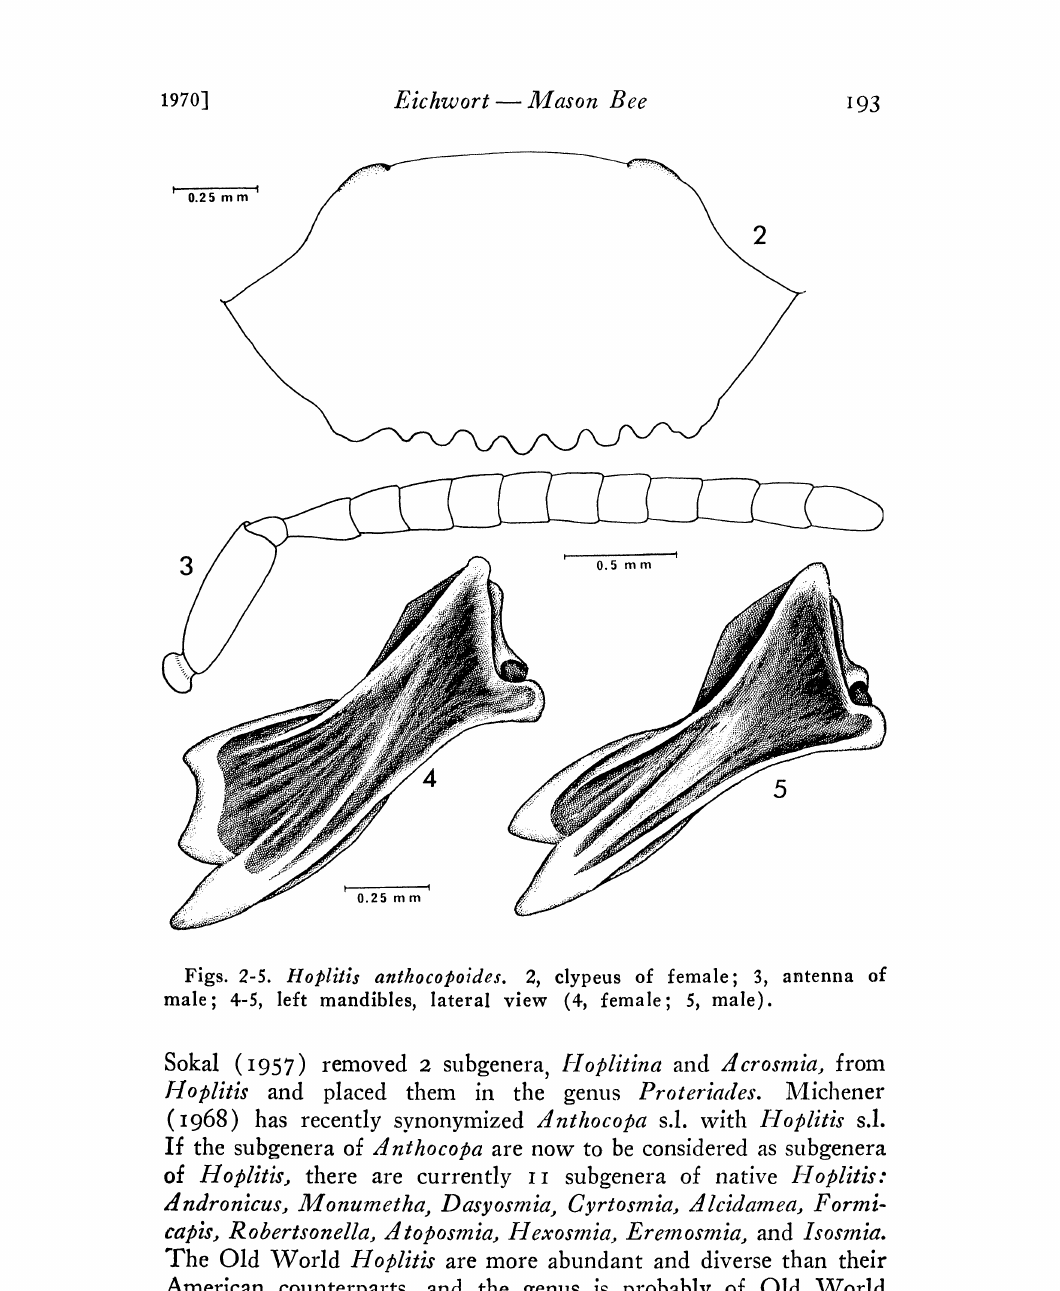
Figs. 2-5. Hoplitis anthocoloides. 2, elypeus of female; 3, antenna male; 4-5, left mandibles, lateral view (4, female; 5,